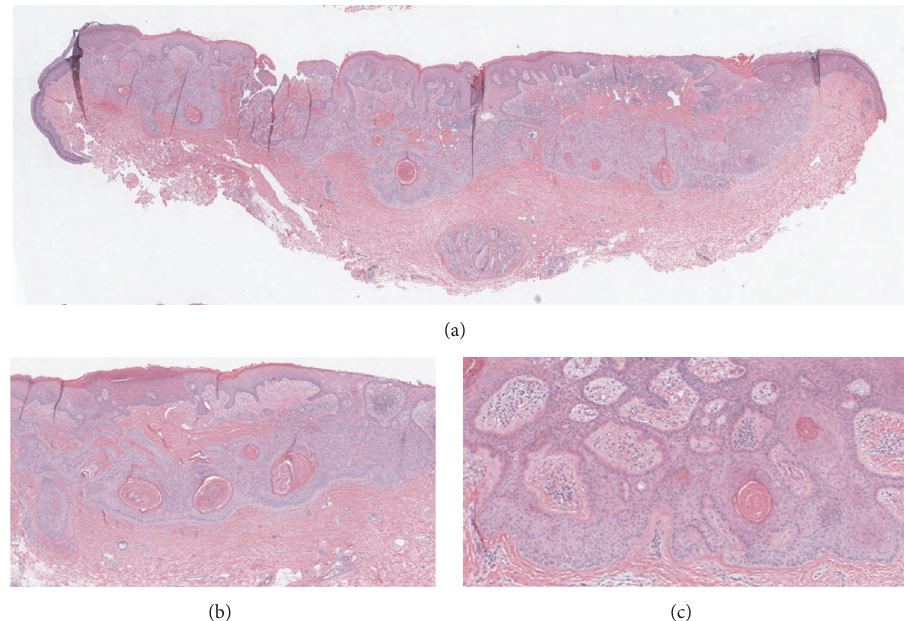
Figure 1: Low power (2x) view of the entire biopsy demonstrating a classic plate-like proliferation of keratinocytes parallel to the epidermis (a). Higher power (10x) of another section of the tumor shows the presence of numerous keratocysts (b) and a net-like architecture with frequent connections of the plate to the above epidermis (c).